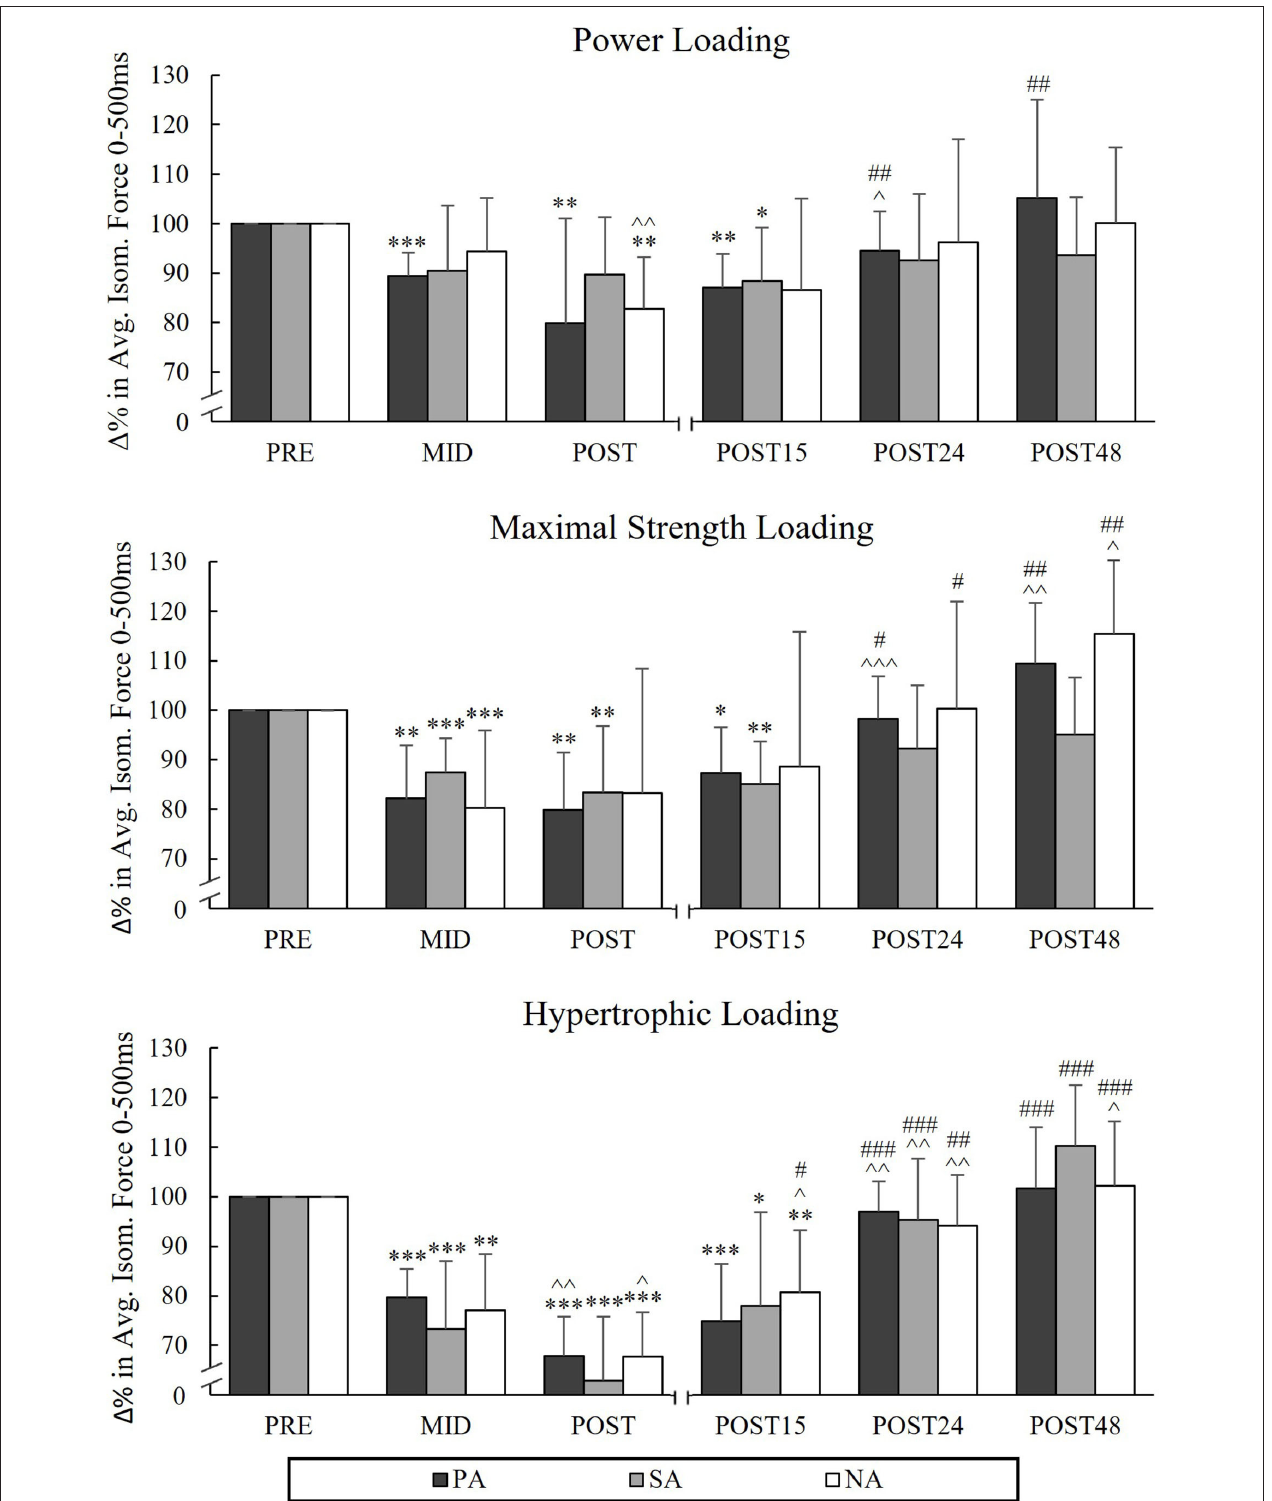
FIGURE 4 | Relative changes in average force in 0–500ms of maximal isometric leg press during three resistance exercise loadings in power (PA), strength (SA), and non-athletes (NA). * p < 0.05, ** p < 0.01, *** p < 0.001 refer to within-group significances compared to Pre. ∧ p < 0.05, ∧∧ p < 0.01, ∧∧∧ p < 0.001 refer to within-group significances compared to the previous time point. # p < 0.05, ## p < 0.01, ### p < 0.001 refer to within-group significances compared to Post during recovery.